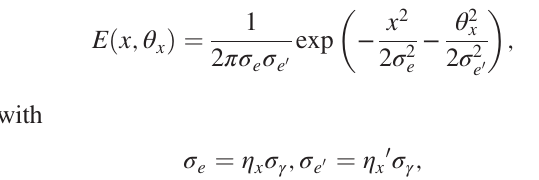
FIG. 7. Optimization of betatron functions. The projected Wigner functions functions and photon energy. The results at the fixed photon energy of 10 keV are plotted in (a) and (b), while the contour plots are shown in (c) and